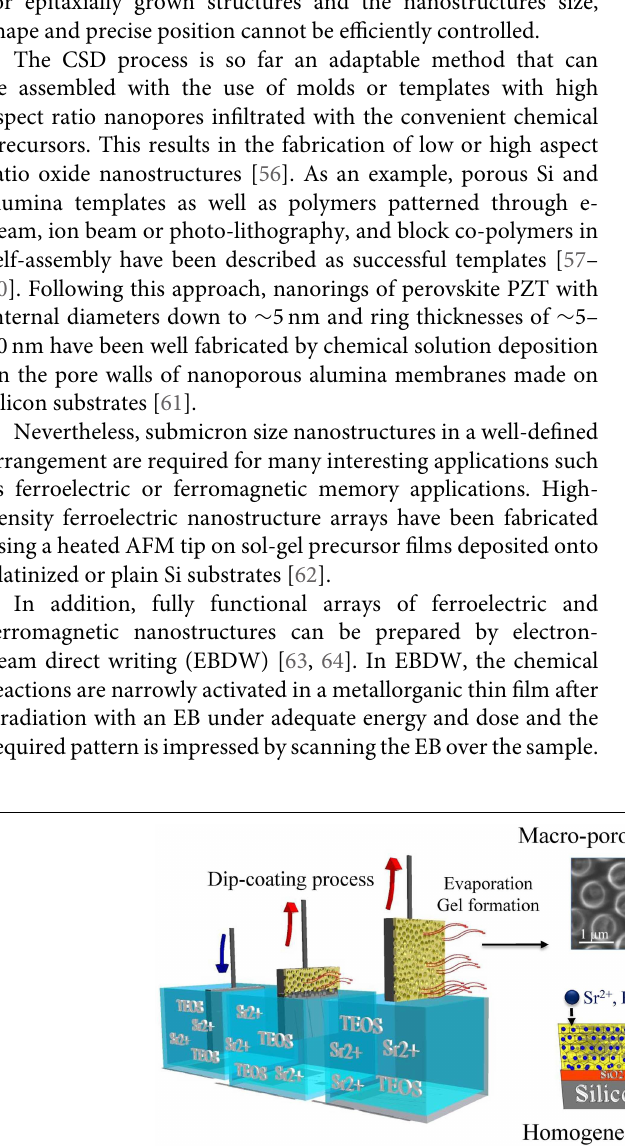
crystallization thin films maintain the initial porous structure achieved at room temperature. The nucleation of crystals quartz at the silicon-silica interface takes place over 900 ◦ C just after a devitrification mechanism that result in a monooriented polycrystalline quartz